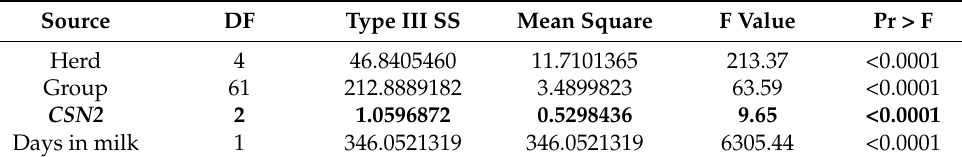
Table 12. Linear model (dependent variable: protein kg).